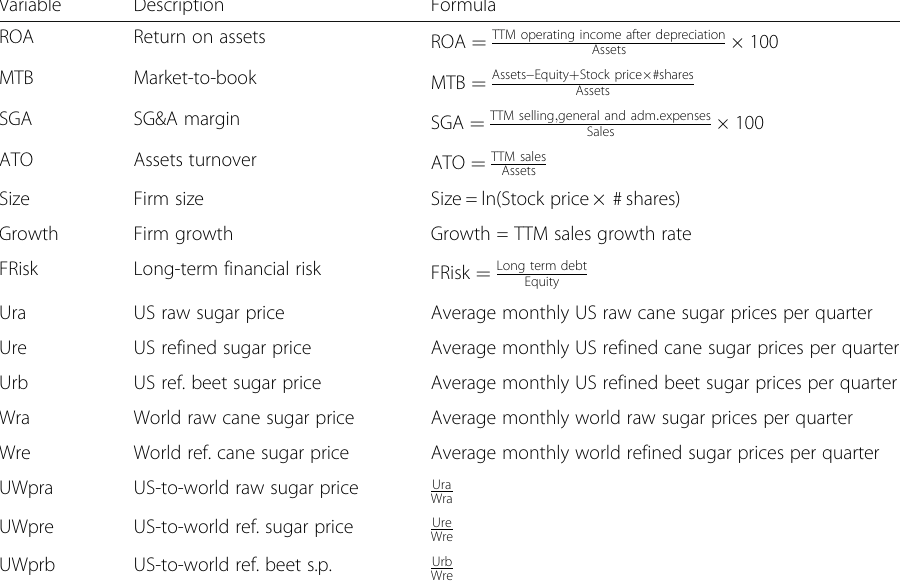
Table 1 Variables description